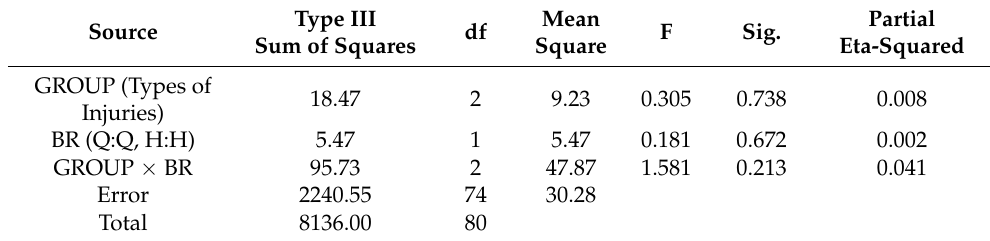
Table 3. Effect of observed factors on the bilateral strength ratio.